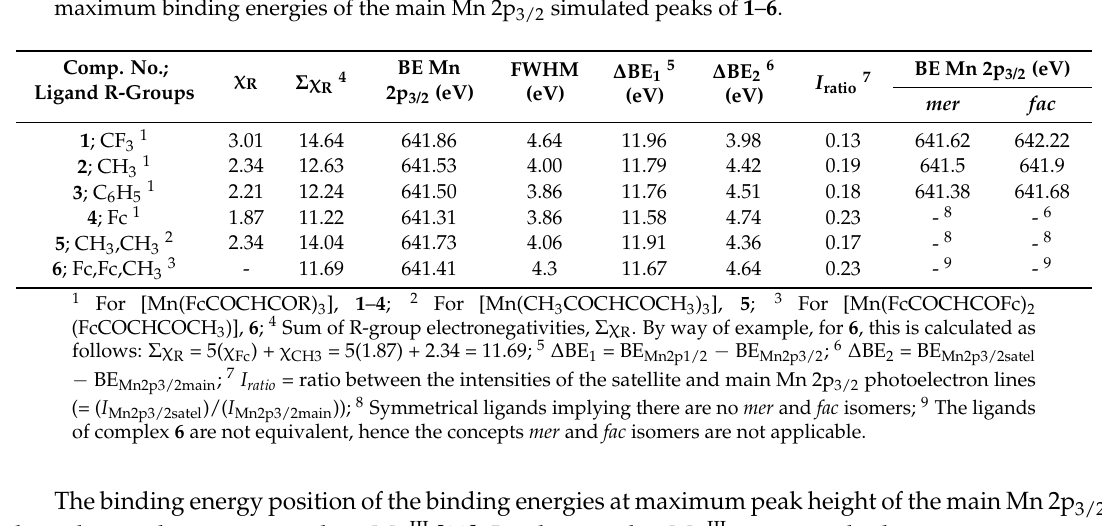
Table 1. χ R and Σ χ R values, maximum binding energies, BE, of the main Mn 2p 3/2 envelope, full width at half maximum (FWHM) values, peak separations between main Mn 2p 3/2 and 2p 1/2 peaks ( ∆ BE 1 ), peak separations between satellite and Mn 2p 3/2 peaks ( ∆ BE 2 ), I ratio values, mer and fac isomer maximum binding energies of the main Mn 2p 3/2 simulated peaks of 1 – 6